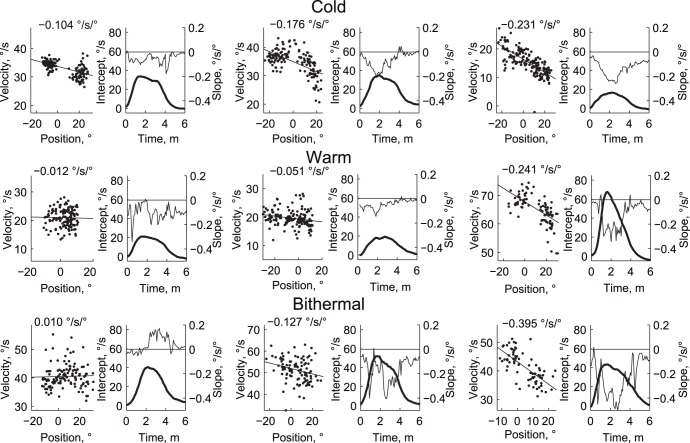
Example velocity versus position plots.Each row contains 2 pairs of plots, each pair showing the data from a different subject. The first plot in each pair is a scatter plot where each point shows the slow phase position and velocity from the 30 seconds centered on the time of maximum nystagmus velocity. The second plot in each pair shows the fitted intercepts (thick line, left-side axis) and slopes (thin line, right-side axis) for the first 6 minutes after the start of caloric stimulation. Each row shows a different stimulation condition (top = cold, middle = warm, bottom = simultaneous bilateral bithermal).